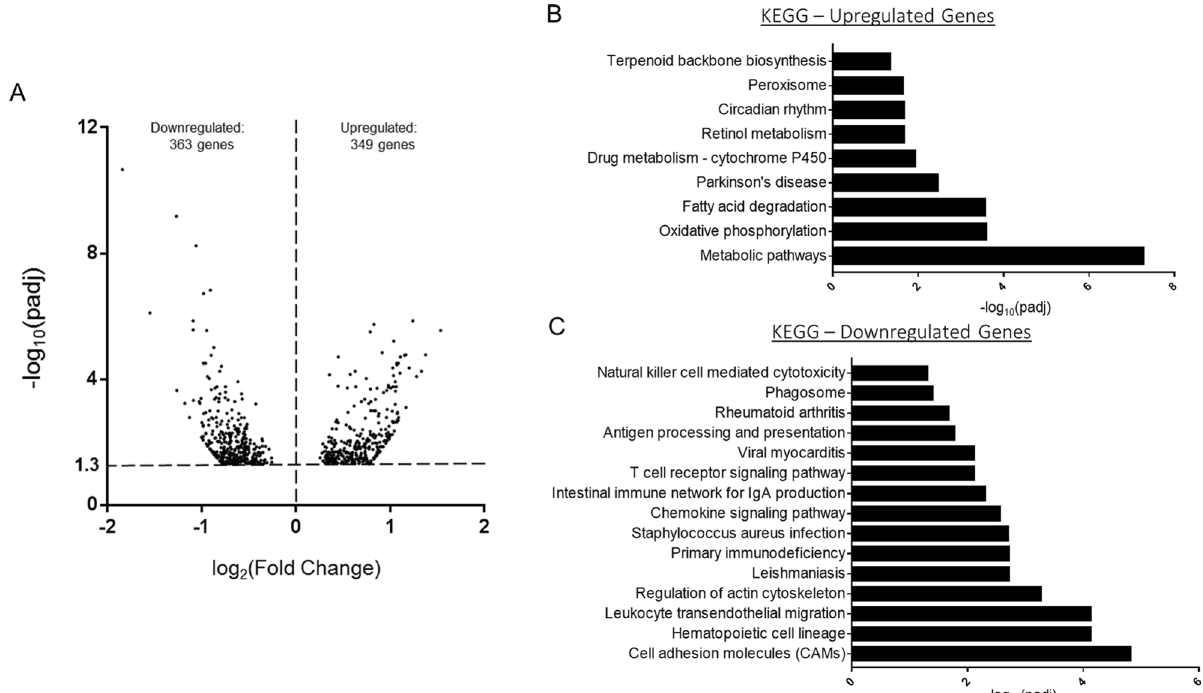
Figure 3. mRNA sequencing analysis of small intestinal epithelial cells 1 day after alcohol and burn injury. ( A ) Volcano plot of differentially expressed genes (padj < 0.05) where each point on the graph represents an individual gene. Log2 fold change between ethanol burn and sham vehicle treated mice is plotted on the x-axis and the − log10 of the padj value is plotted on the y-axis. Overall, mRNA sequencing analysis identified 712 differentially expressed genes (including 349 upregulated genes and 363 downregulated genes). ( B , C ) KEGG Pathway enrichment analysis of differentially expressed genes. Each bar represents a KEGG pathway found to